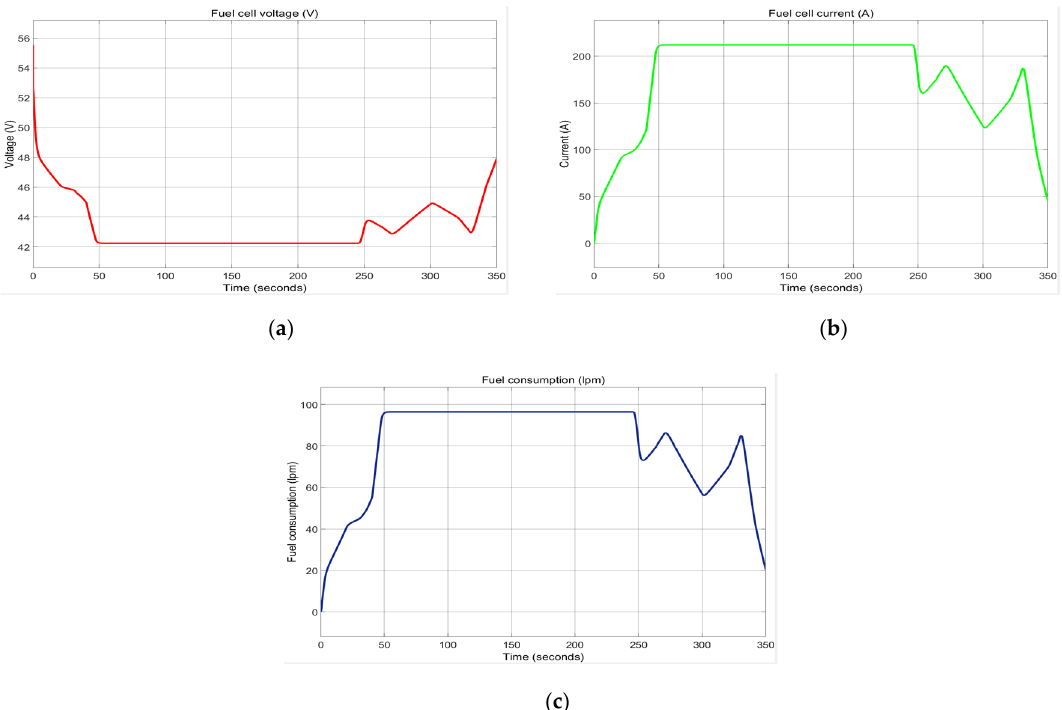
Batteries 2020 , 6 , x FOR PEER REVIEW Figure A8. Fuel cell. ( a ) FC current; ( b ) FC voltage; ( c ) FC consumption.